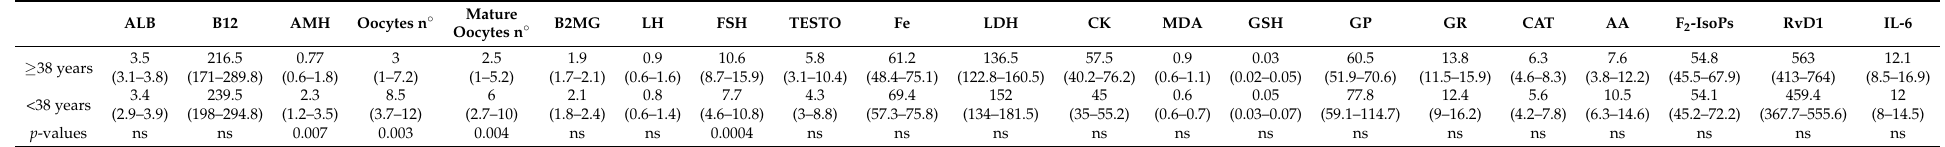
Table 1. Medians and 25 ◦ –75 ◦ centiles (in parenthesis) of albumin (ALB), vitamin B12 (B12), anti-Müllerian hormone (AMH), number of oocytes, number of mature oocytes, beta-2-microglobulin (B2MG), luteinising hormone (LH), follicle stimulating hormone (FSH), testosterone (TESTO), iron (Fe), lactate dehydrogenase (LDH), total creatine kinase (CK), malondialdehyde (MDA), glutathione (GSH), glutathione peroxidase (GP), glutathione reductase (GR), catalase (CAT), ascorbic acid (AA), F 2 -isoprostanes (F 2 -IsoPs), resolvin (Rv)D1, and Interleukin-6 (IL-6) assayed in follicular fluids of 72 infertile women divided into 2 groups according to their age ( ≥ 38 years, <38 years). In the last row, for each variable, the p -value of the Wilcoxon test. When p -value is greater than 0.05, ns, which stands for not significant, is reported.